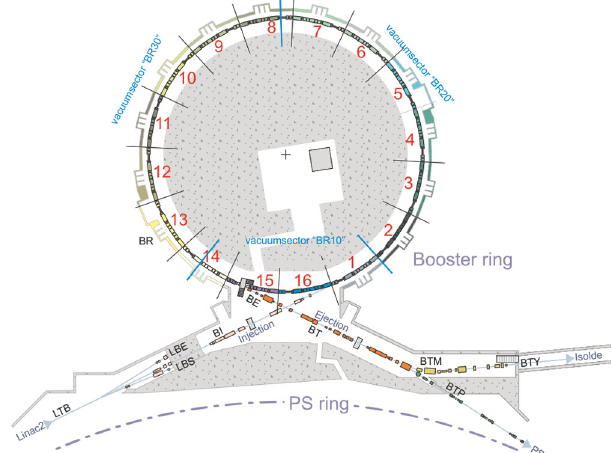
FIG. 1. PSB layout [11] before the LIU. The beam is transferred from Linac2 to the PSB and then extracted at 1.4 GeV to ISOLDE via the BTY transfer line. The BTP line transfers the beam to the downstream accelerator